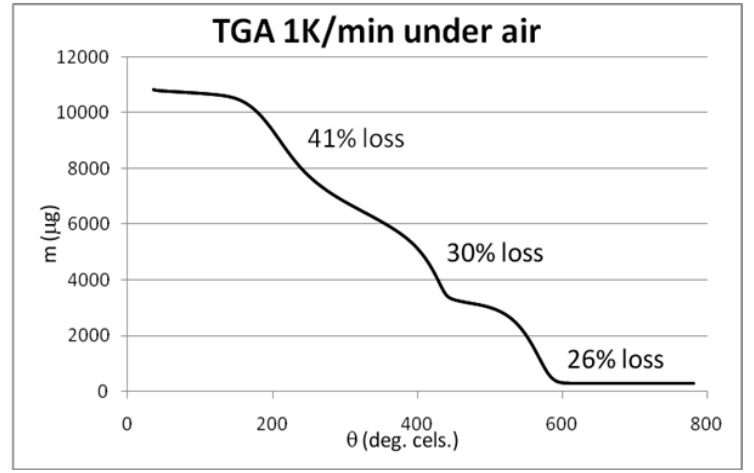
Figure 13. TGA analysis of brominated MWCNT sample CNT1 at 1 K/min.